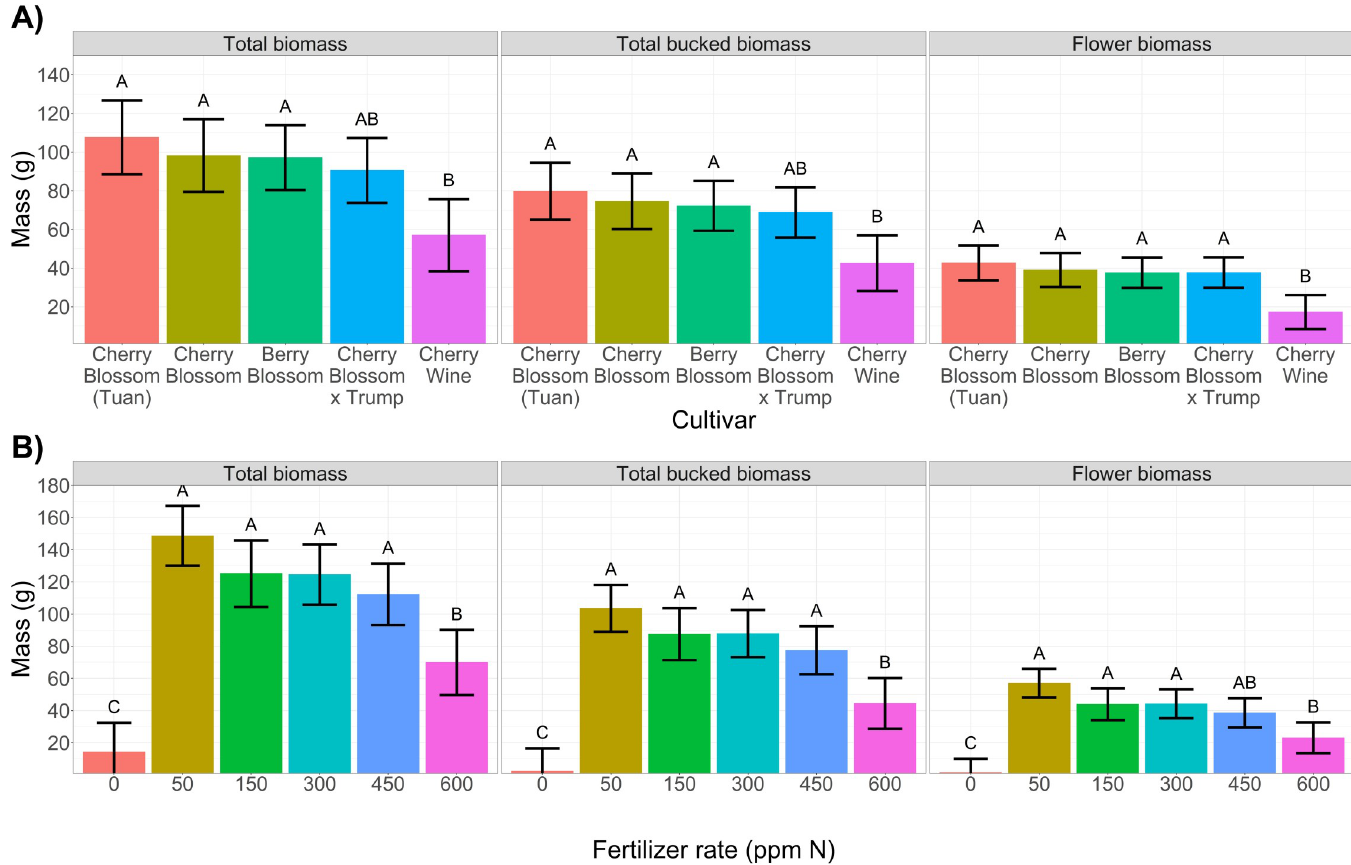
Fig 4. [A] Bar graphs depicting cultivar best linear unbiased estimator (BLUE) values for biomass traits total biomass, bucked biomass (flower and leaves), flower biomass (left to right). Error bars depict the 95% confidence intervals and connecting letters indicate statistical differences using Tukey’s HSD ( α = 0.05). [B] Bar graphs depicting fertilizer treatment BLUE values for biomass traits total biomass, bucked biomass (flower and leaves), flower biomass (left to right). Error bars depict the 95% confidence intervals and connecting letters indicate statistical differences using Tukey’s HSD ( α = 0.05).